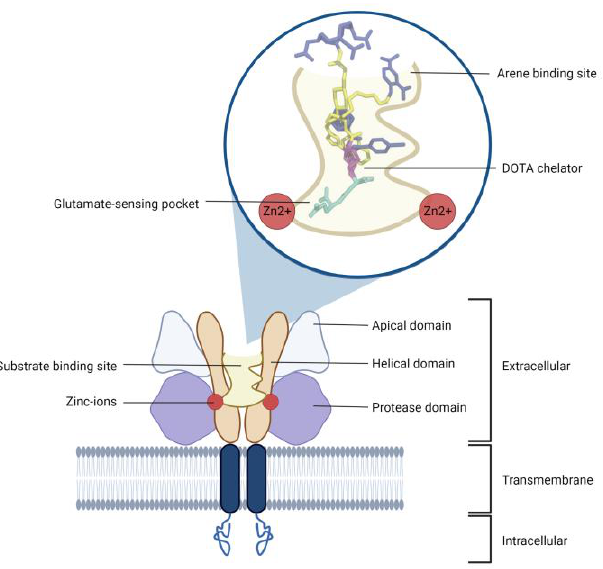
Figure 1. Schematic overview of the structure of a PSMA receptor. DOTA = 1,4,7,10-tetraazacyclododecane-1,4,7,10-tetraacetic acid; PSMA = prostate-specific membrane antigen.